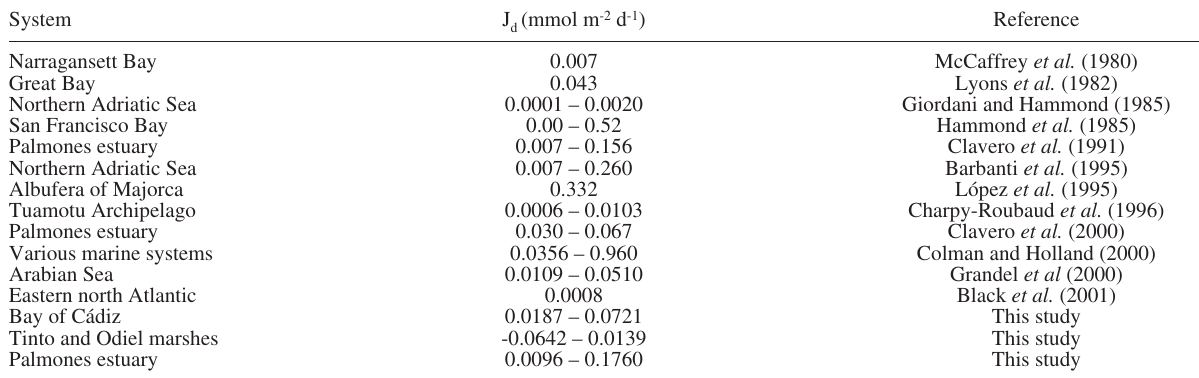
Table 5. – Comparison of phosphate diffusive fluxes in this study with other systems